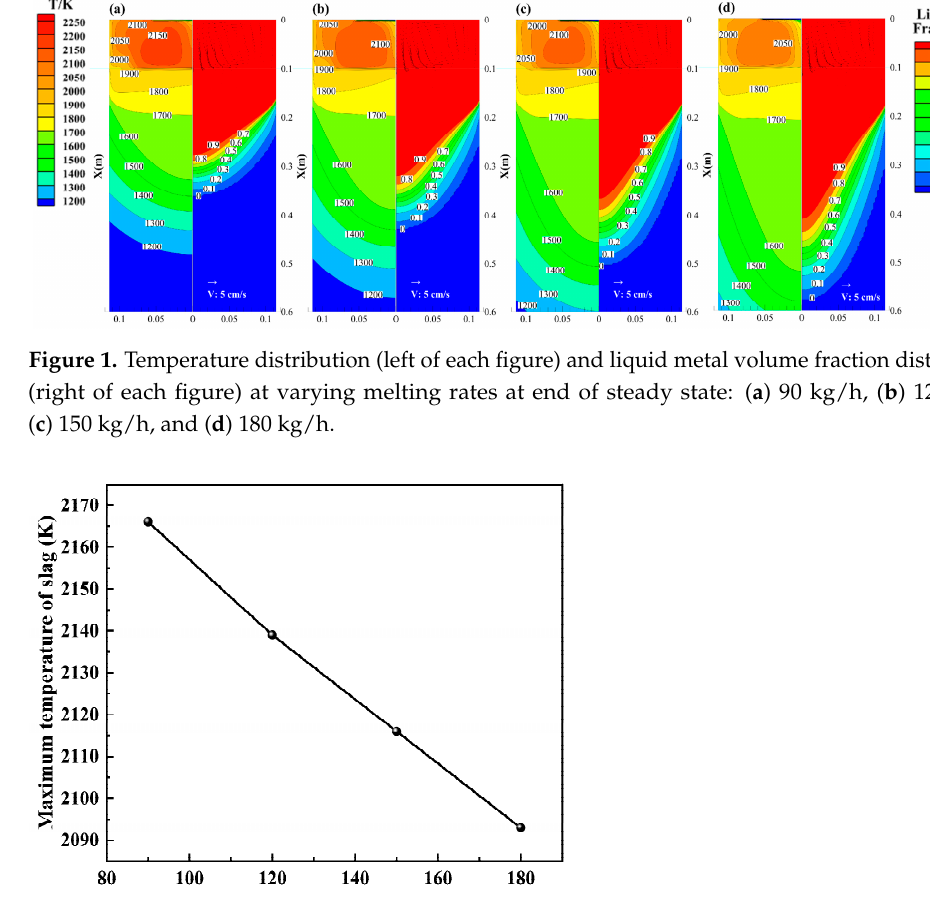
Figure 2. Effect of melting rate on maximum slag temperature.